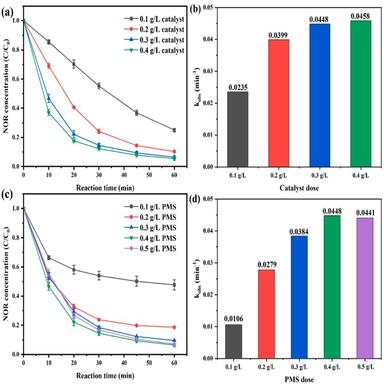
The effect of catalyst (a) and PMS (c) dose, rate constants (b, d). (General condition: = 10 mg/L, PMS = 0.4 g/L, catalyst = 0.3 g/L, without adjusting the initial pH, T = 25±0.1◦C. The error bars represent results of three duplicates.).